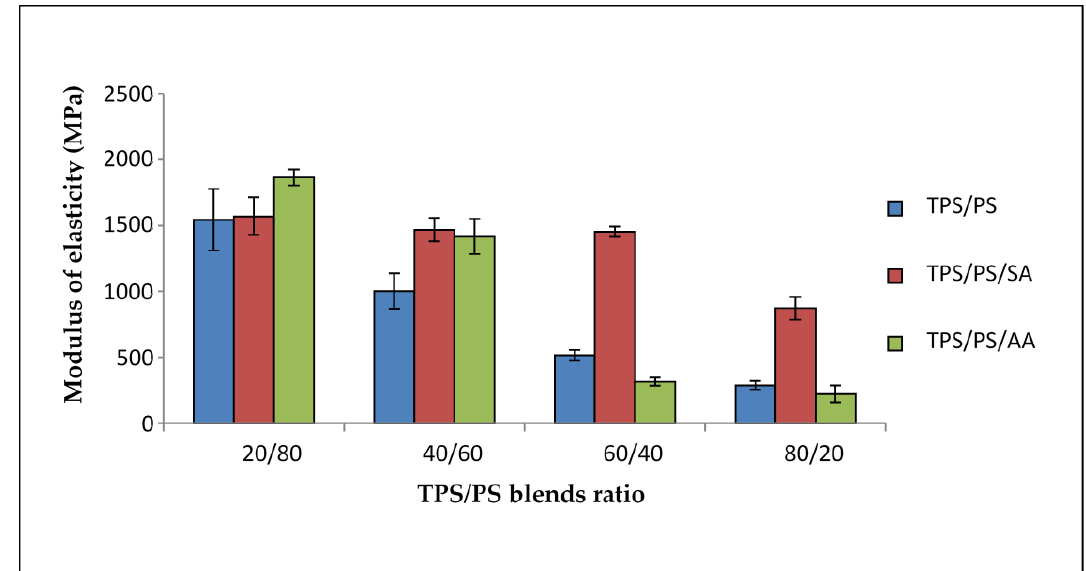
Figure 5. Modulus of elasticity of treated TPS/PS with AA and SA at different blend ratios.